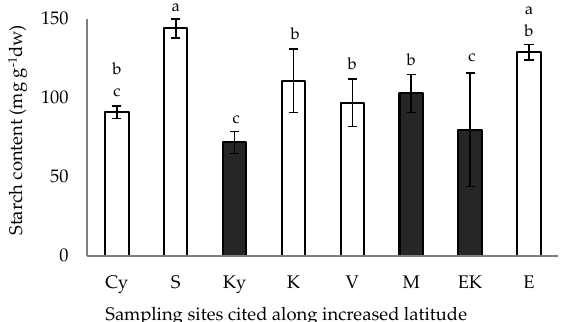
Figure 4. Starch content of the fruit pericarp of C. spinosa harvested from inland (closed bars) and coastal habitats (open bars) cited along increased latitude. The values are means ± standard deviation; significant difference ( p < 0.05) of mean values was detected using Kruskall–Wallis’ test and is marked using lowercase letters, according to post hoc